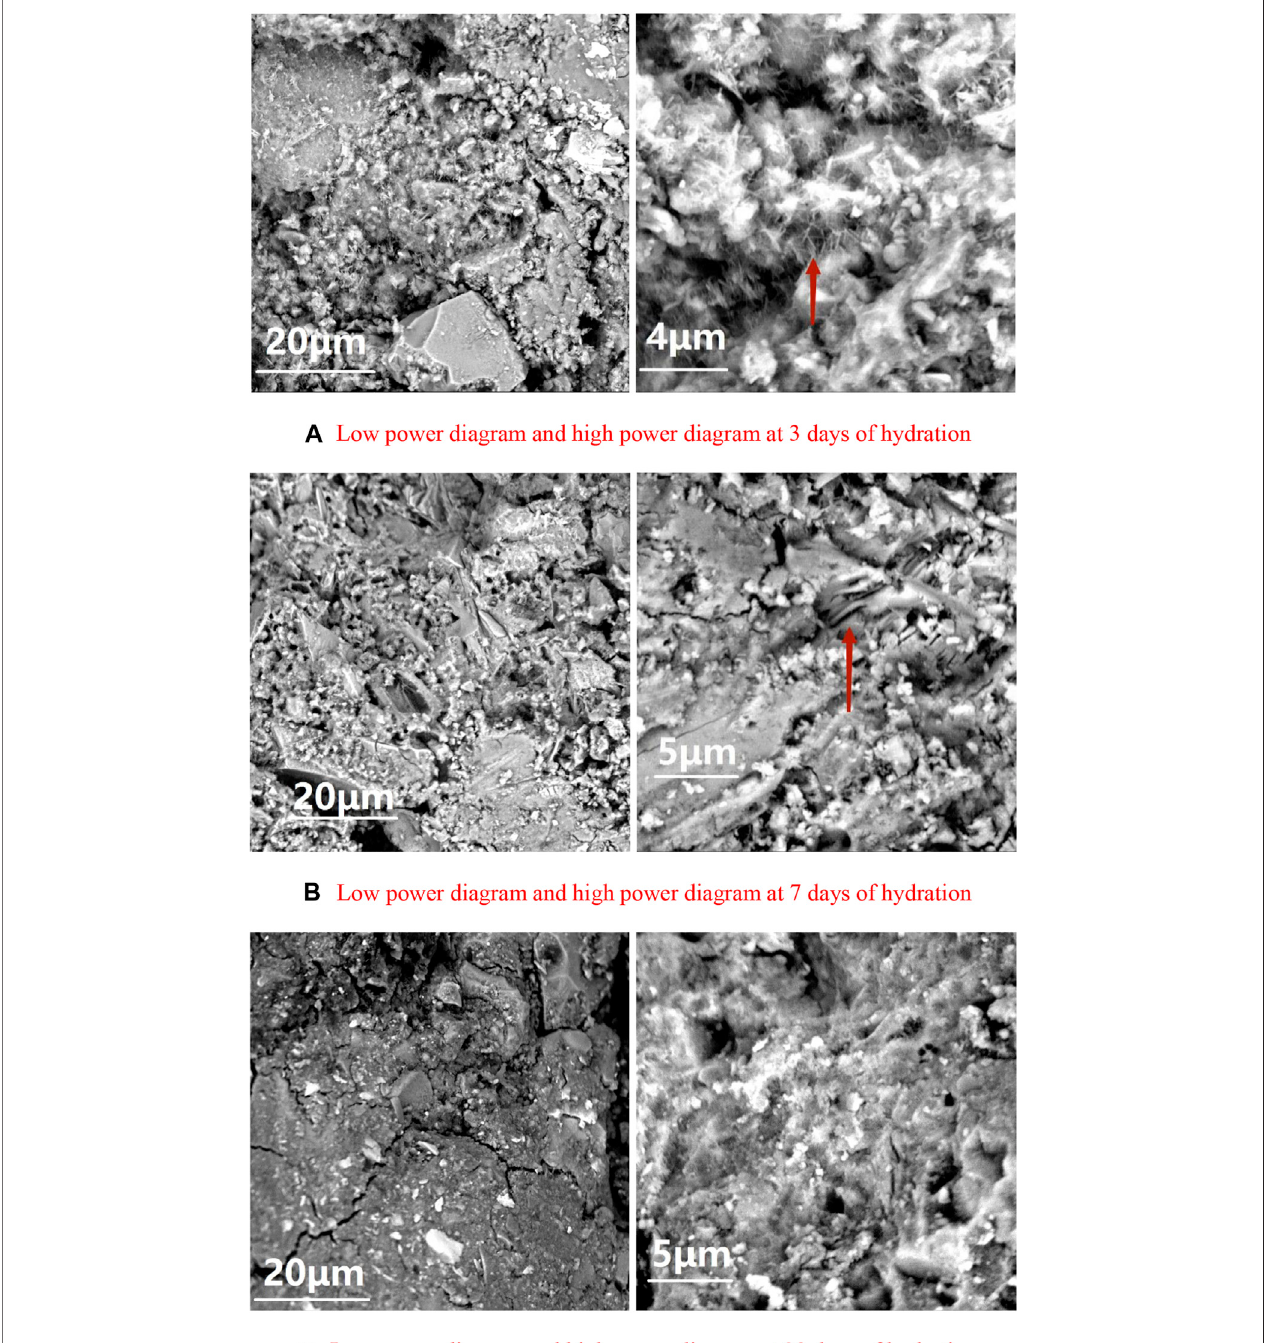
FIGURE3| SEMimagesofpastesatdifferentages (A) Day3 (B) Day7 (C) Day28. (A) Lowpowerdiagramandhighpowerdiagramat3 daysofhydration. (B) Low power diagram and high power diagram at 7 days of hydration. (C) Low power diagram and high power diagram at 28 days of hydration.